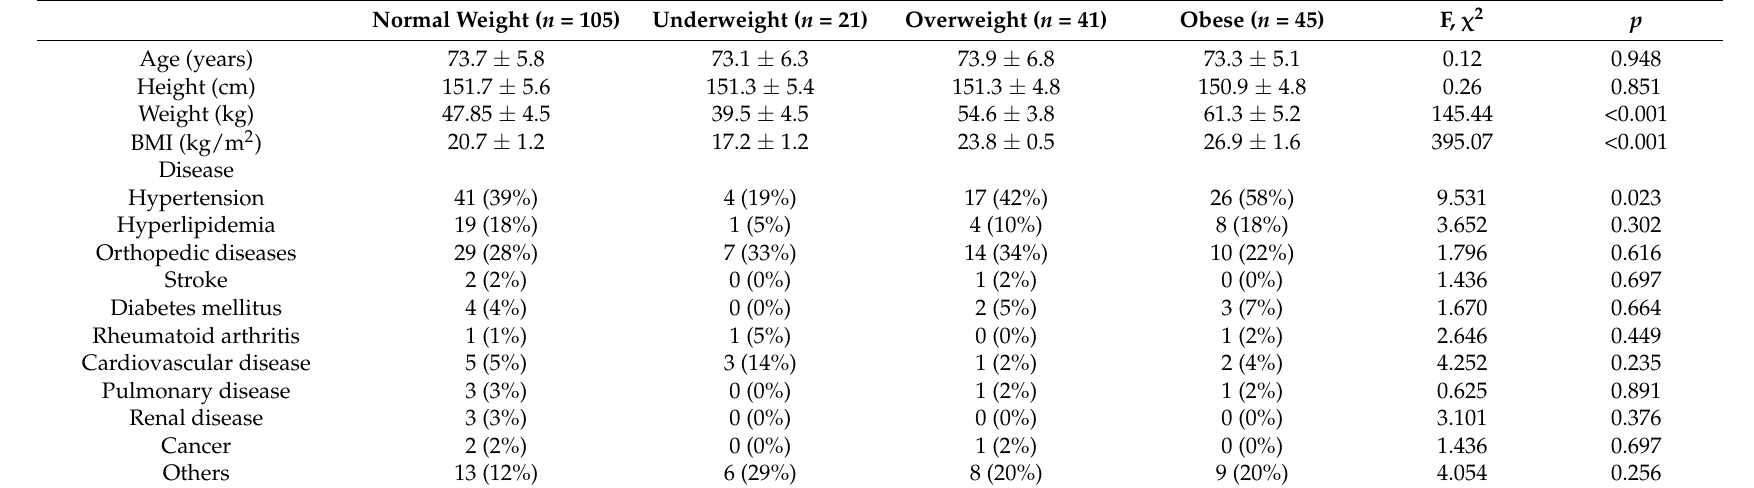
Table 1. Participant characteristics.